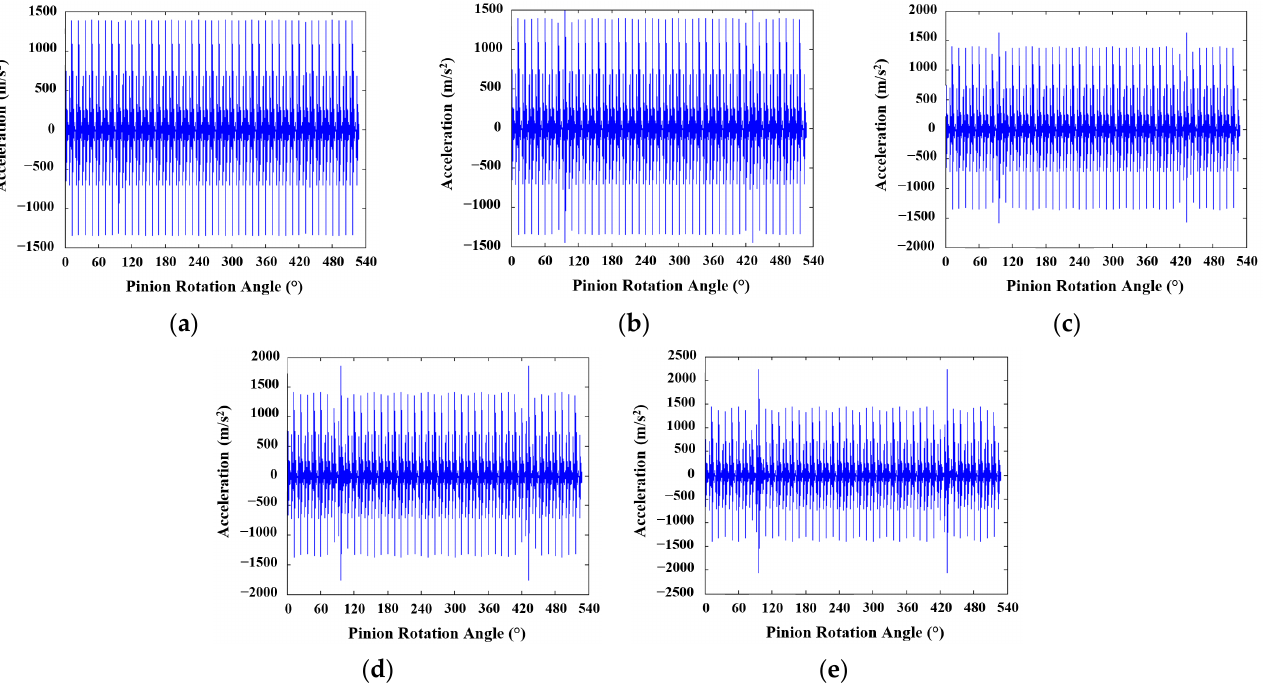
Figure 6. Vibration signals obtained for 20 ◦ /20 ◦ tooth profile: ( a ) healthy; ( b ) 25%; ( c ) 50%; ( d ) 75%; ( e ) 100% crack levels.